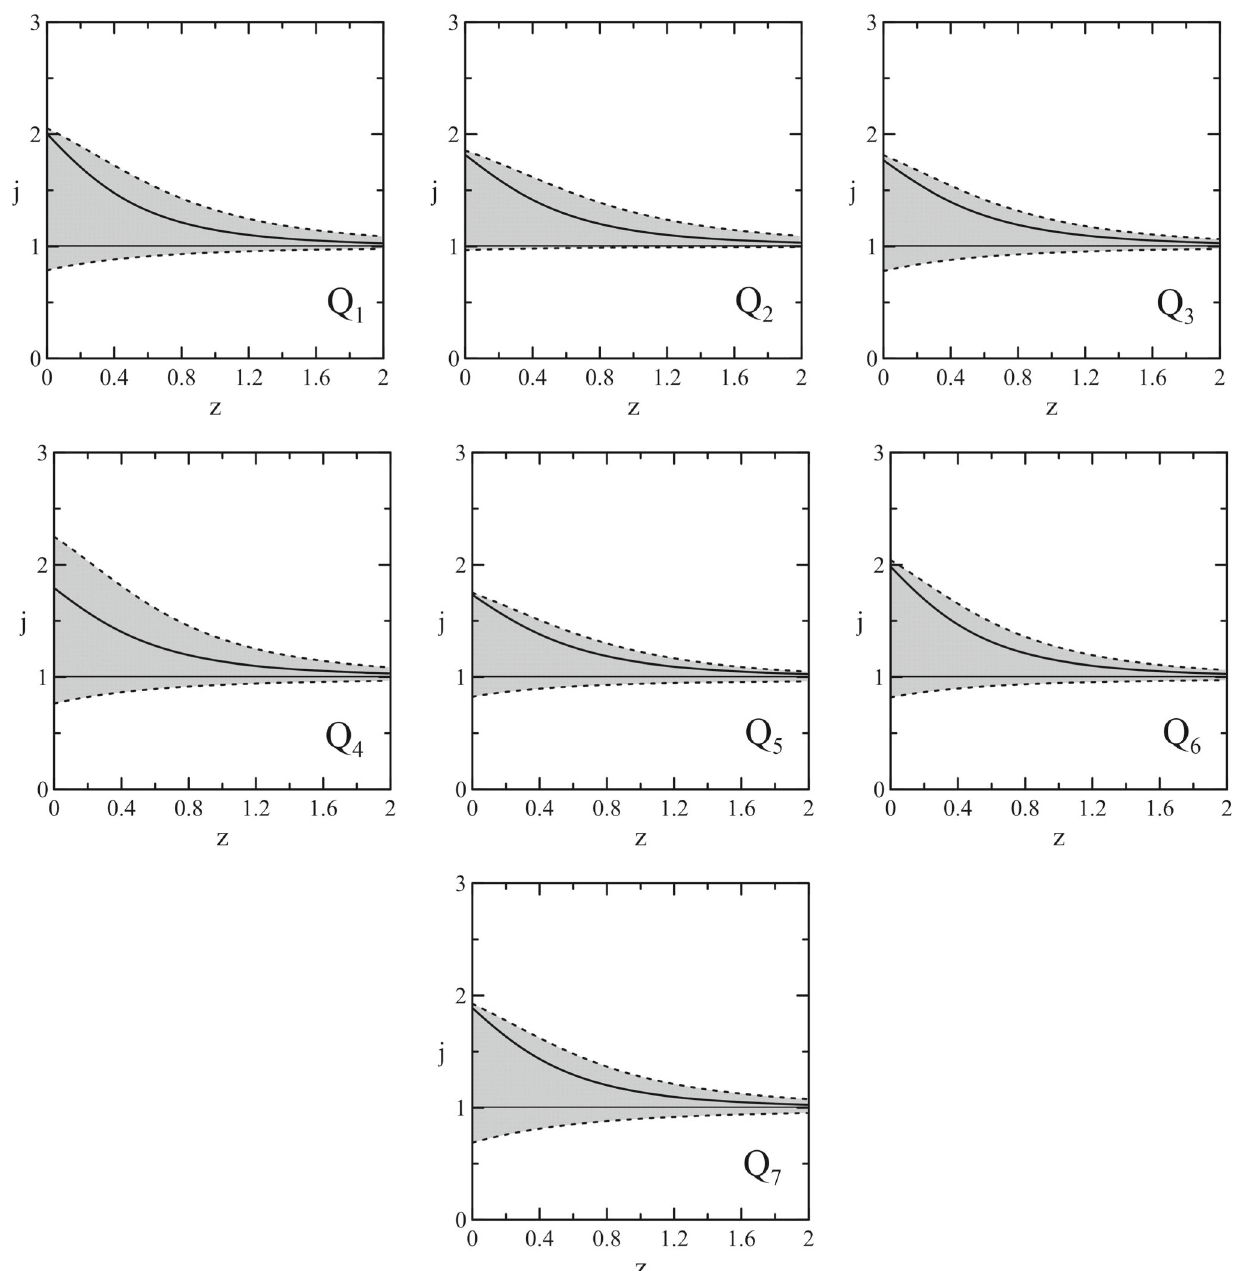
Fig. 4 The evolution of the jerk parameter in terms of redshift for EHRDE model (Eqs. (21) and (22)) with the corresponding 1 σ inter- val level according to the best fitted value listed in Tables 4 and 5 and